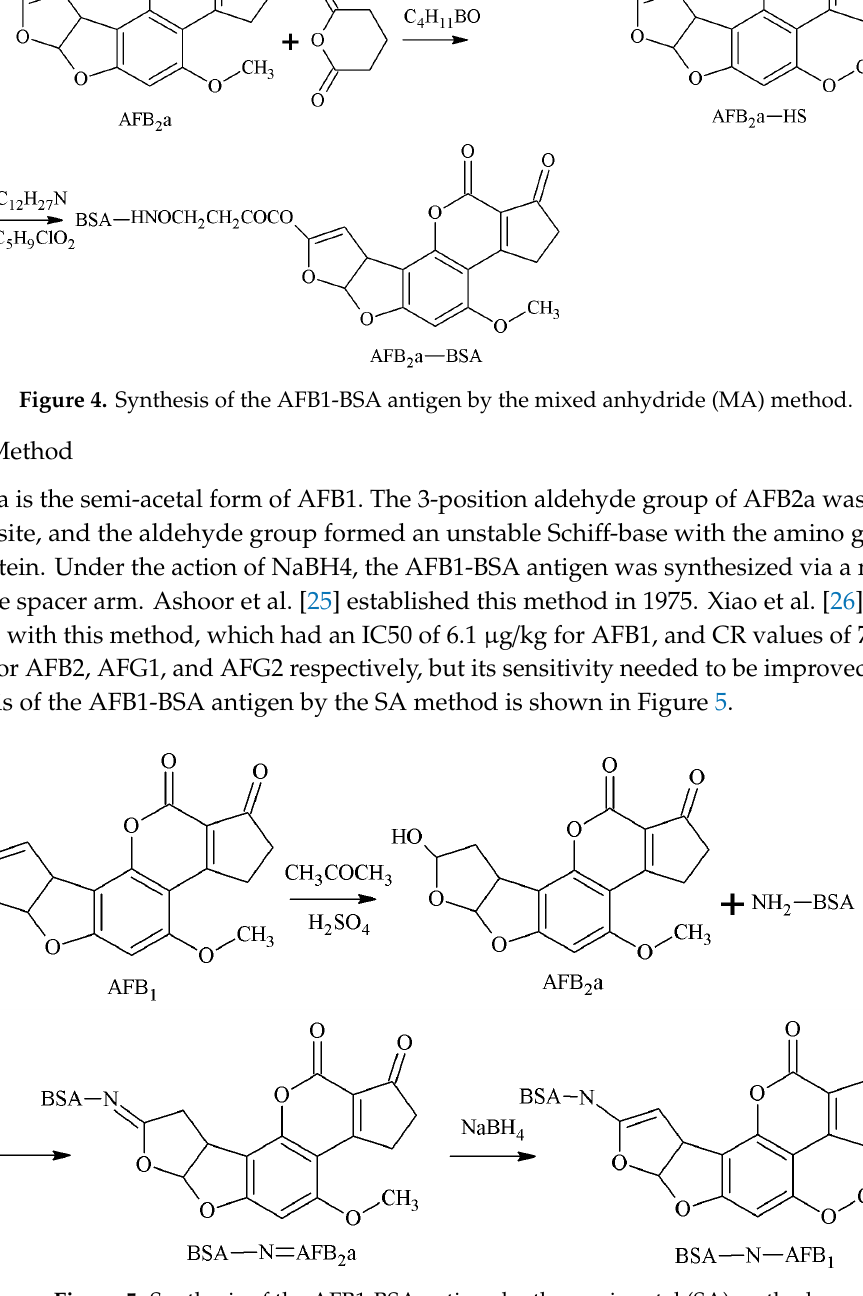
Figure 6. Synthesis of the AFB1-BSA antigen by the epoxide (EP) method. 2.1.6. EED Method The 3-4-position double-furan ring of AFB1 was selected as the active site, and AFB1-glycolic acid was obtained via reaction with glycolic acid. The carboxyl group of the AFB1-glycolic acid was combined with a carrier protein to synthesize the antigen. Cervino et al. [29] established this method in 2007 and prepared AFB1 pAb and AFB1 mAb that 100% identified AFB1 and AFB2, but the